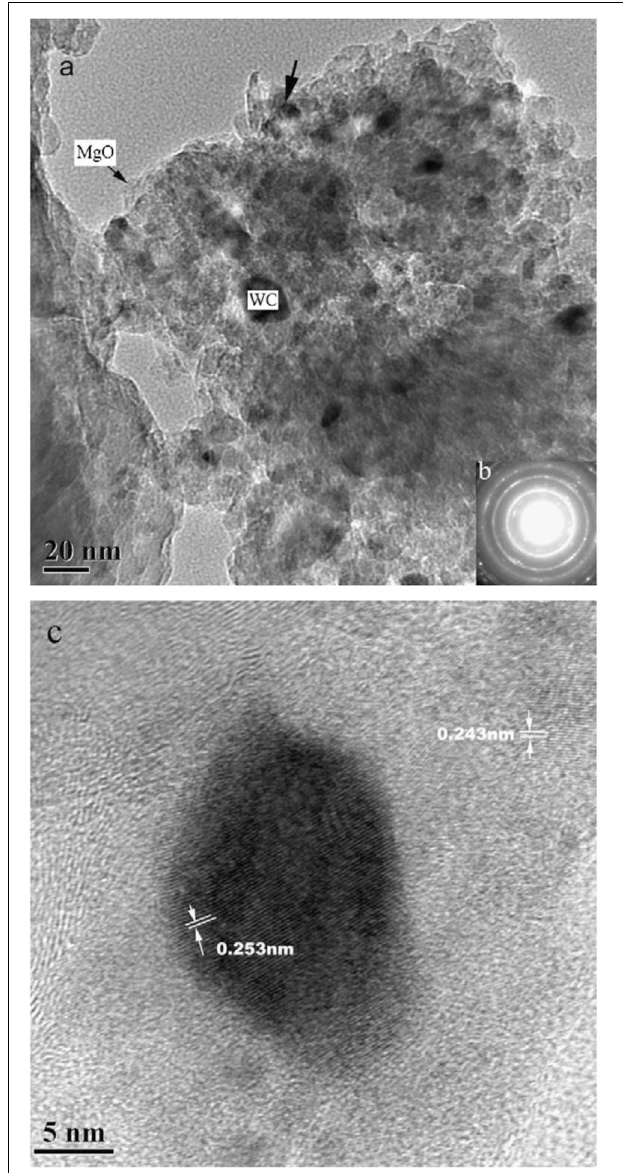
FIGURE 10 | High-power microscopic image of WC powders after 80 h of ball milling: (a) High power micrograph; (b) the selected-area diffraction pattern; (c) enlarged micrograph of selected-area (Wu et al., 2009) [Figure 3 of Wu et al. (2009), Copyright Elsevier